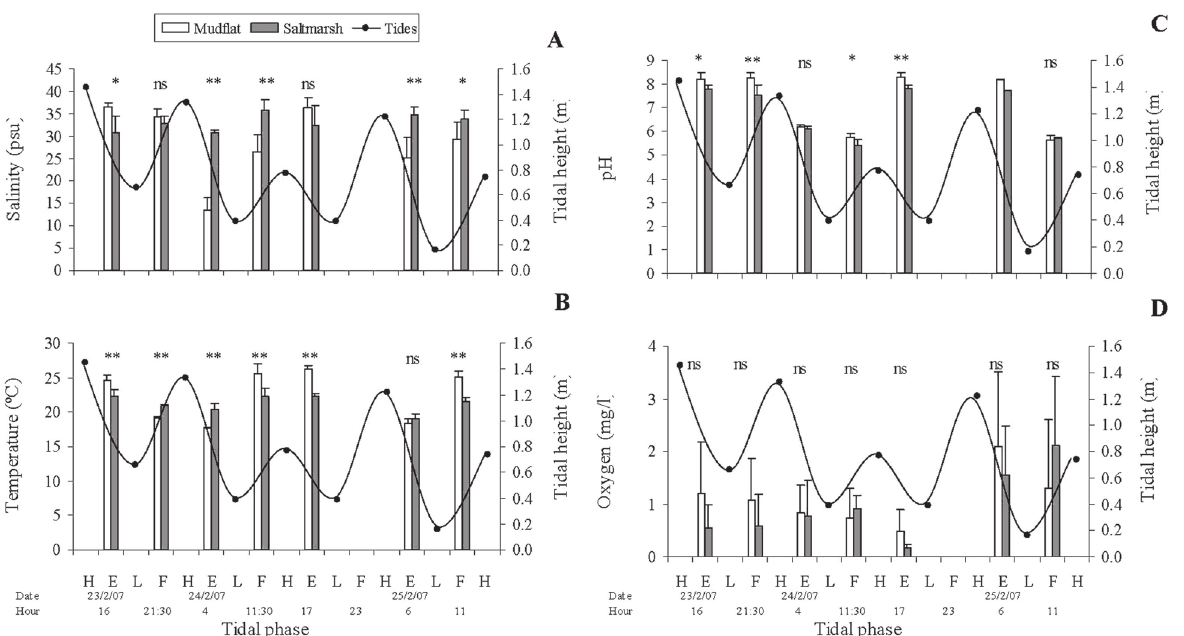
Fig . 2. – Neohelice granulata . (A) Temperature (ºC), (B) salinity (psu), (C) pH and (D) dissolved oxygen (mg/l) of water sampled from burrows in a mudflat and a salt marsh; flood (F) vs ebb (E) tide; February 23, 4:00 Pm to February 25, 2007, 11:00 am; high (H) vs low (l) tide. Statistical test for differences between habitats (Student’s t -test): P <0.001 (**), P <0.05 (*), not significant Table 1. – Neohelice granulata . average biomass and reproduc- tive effort (rE) of females from mudflats and salt marshes (mean ± Sd). differences (d) between habitats tested with Student’s t -test: P <0.001 (***), P <0.05 (**), not significant (ns).